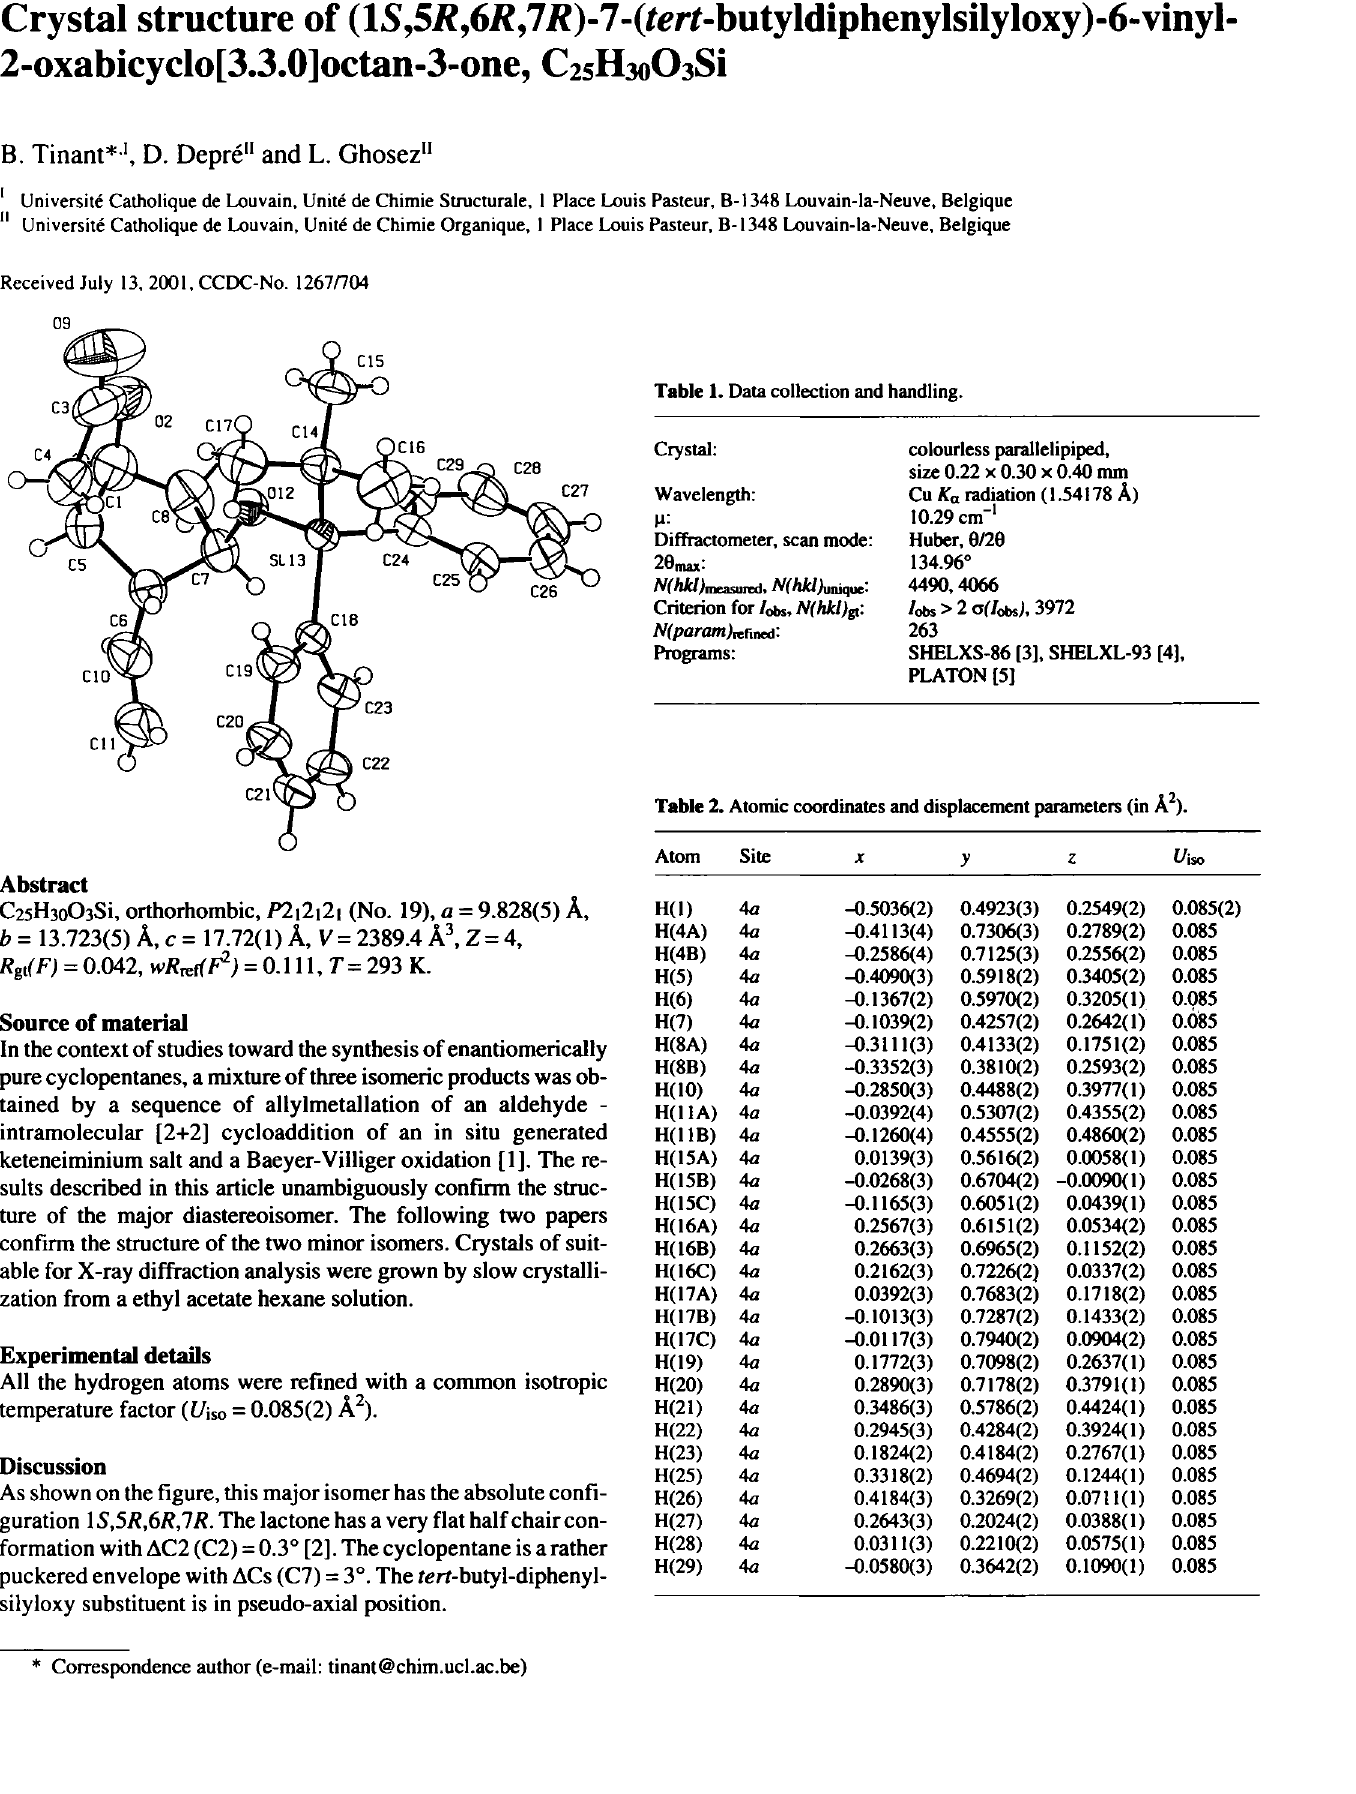
Table 1. Data collection and handling.